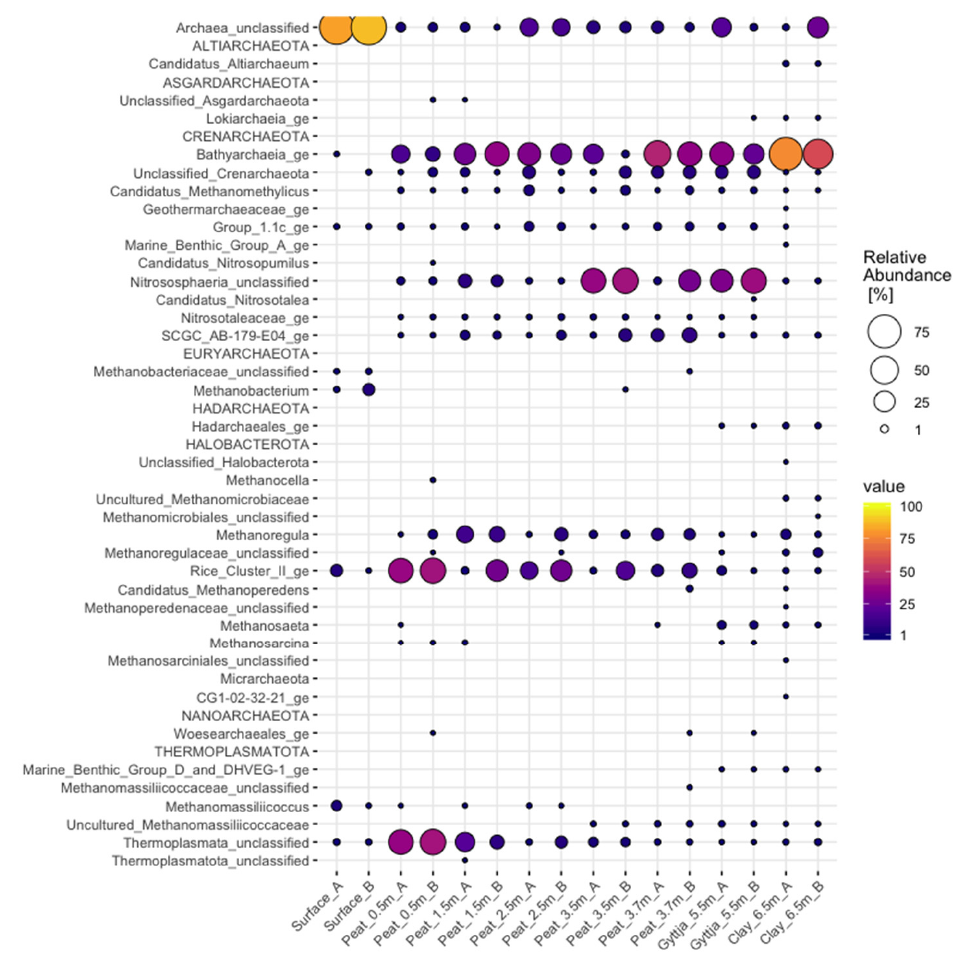
Figure A1. Relative abundance of archaeal genera in surface moss, peat, gyttja, and clay samples collected from Lastensuo bog.